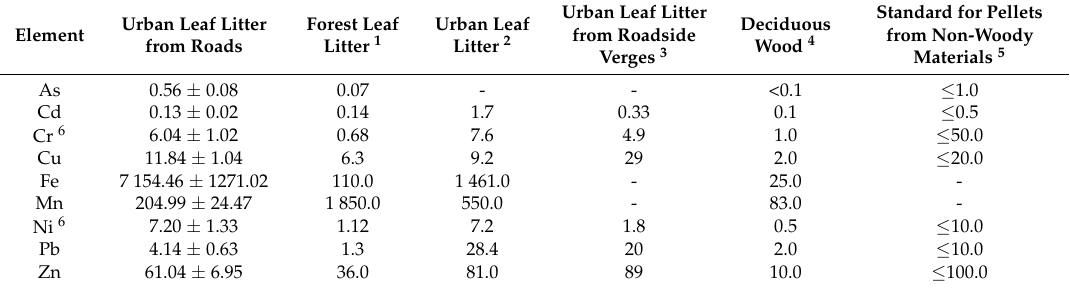
Table 1. Mean concentrations of heavy metals (mg · kg − 1 DM) ± standard error of means (s.e.) in leaf litter from different origins in comparison to wood and a German standard for pellets from non-woody